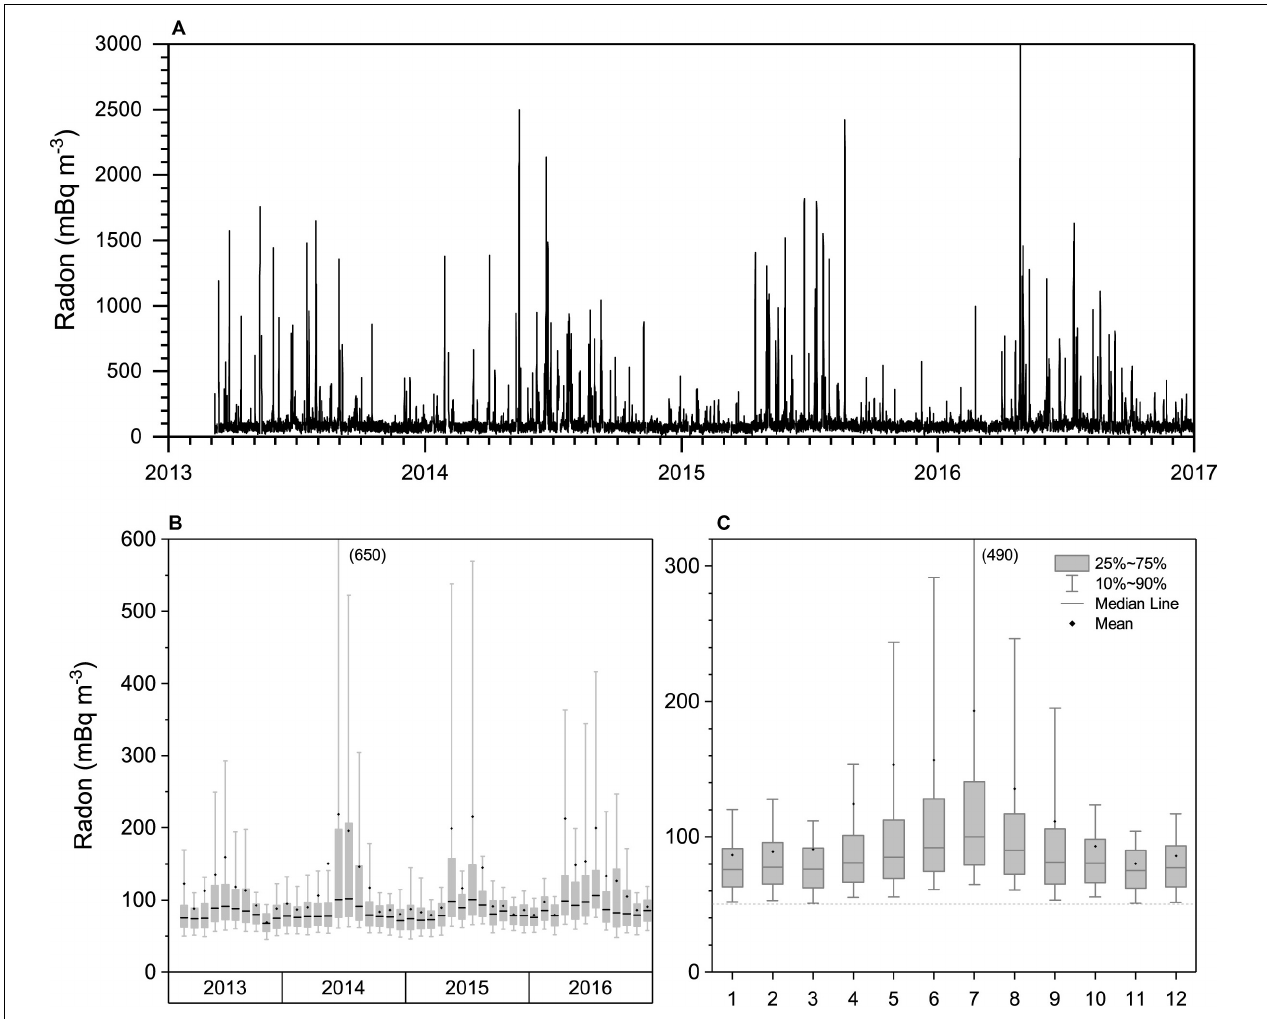
FIGURE 4 | (A) Hourly, and (B,C) monthly distributions of radon concentrations at Macquarie Island based on a 4-year (2013–2016) composite of hourly observations. Refer to key for distribution box-plot